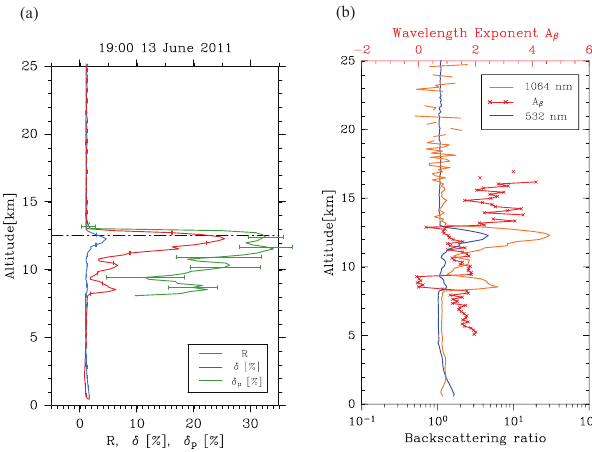
Fig. 6 Figure 6. (a) Vertical profiles of the backscattering ratio R (blue line), the total depolarization ratio δ (red line), and the particle de- polarization ratio δ p (green line) at 532nm on 13 June. The hori- zontal dot-dash line in left panel (a) shows tropopause height. (b) Vertical profiles of the backscattering ratio at 532nm (blue line), the backscattering ratio at 1064nm (orange line), and the wavelength exponent of the backscattering ratios ( A β ) at 1064nm/532nm (red line) on 13